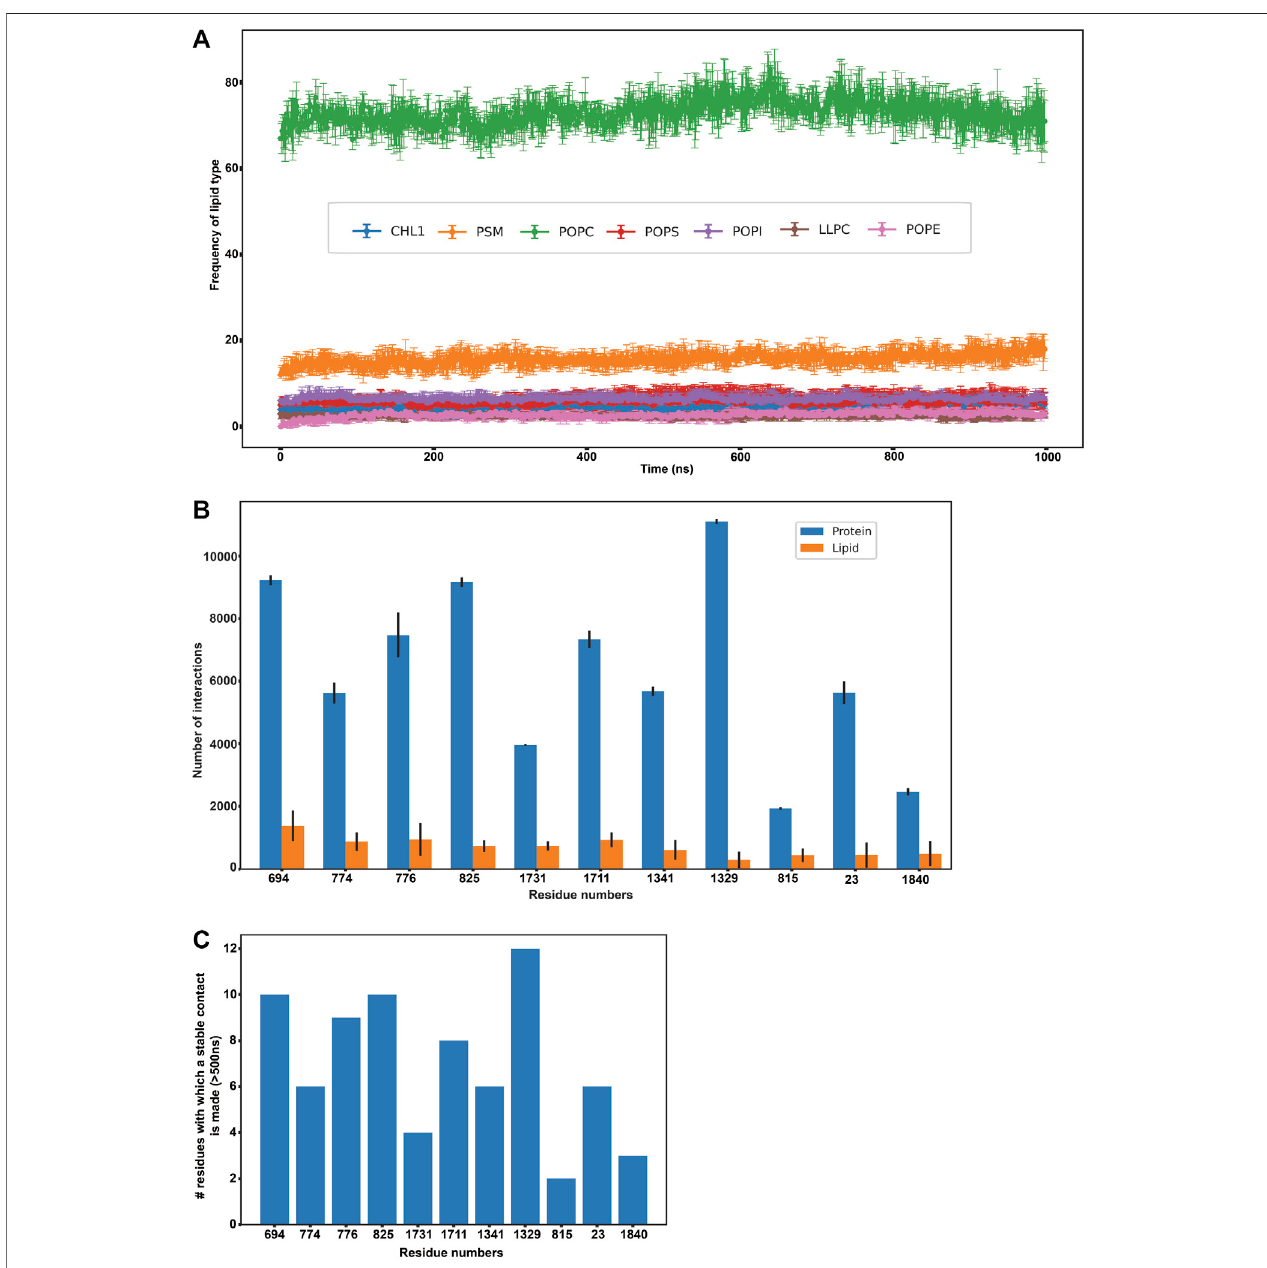
FIGURE3| Protein-lipidinteractions ’ analysis. (A) Frequencyofeachlipidtypesurroundingtheproteinresidueswithinaradiusof0.5 nmthroughoutoursimulation (B) Frequency of protein-protein and protein-lipid interactions of the eleven disease-related protein residues (C) Number of stable protein-protein contacts made by the eleven disease-related protein residues ( > 500 ns of simulation